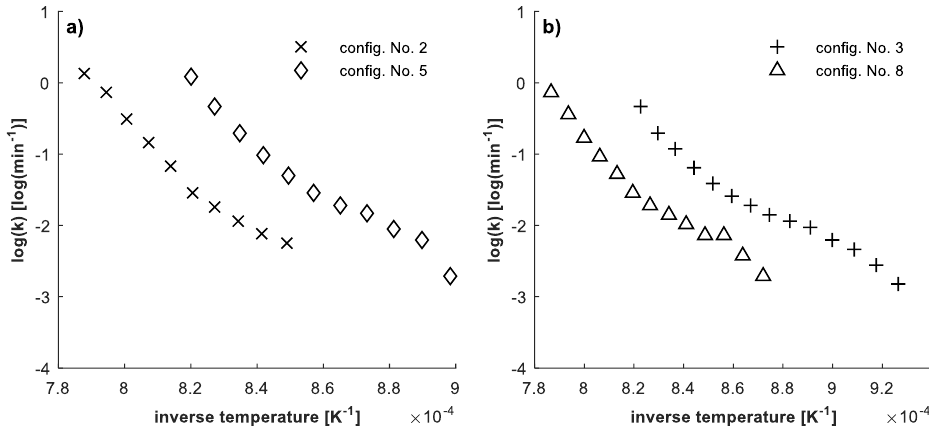
Figure 2. Arrhenius plot for ( a ) CO₂ gasification (configurations No. 2, 5) and ( b ) steam gasification (configuration No. 3, 8) (VM).